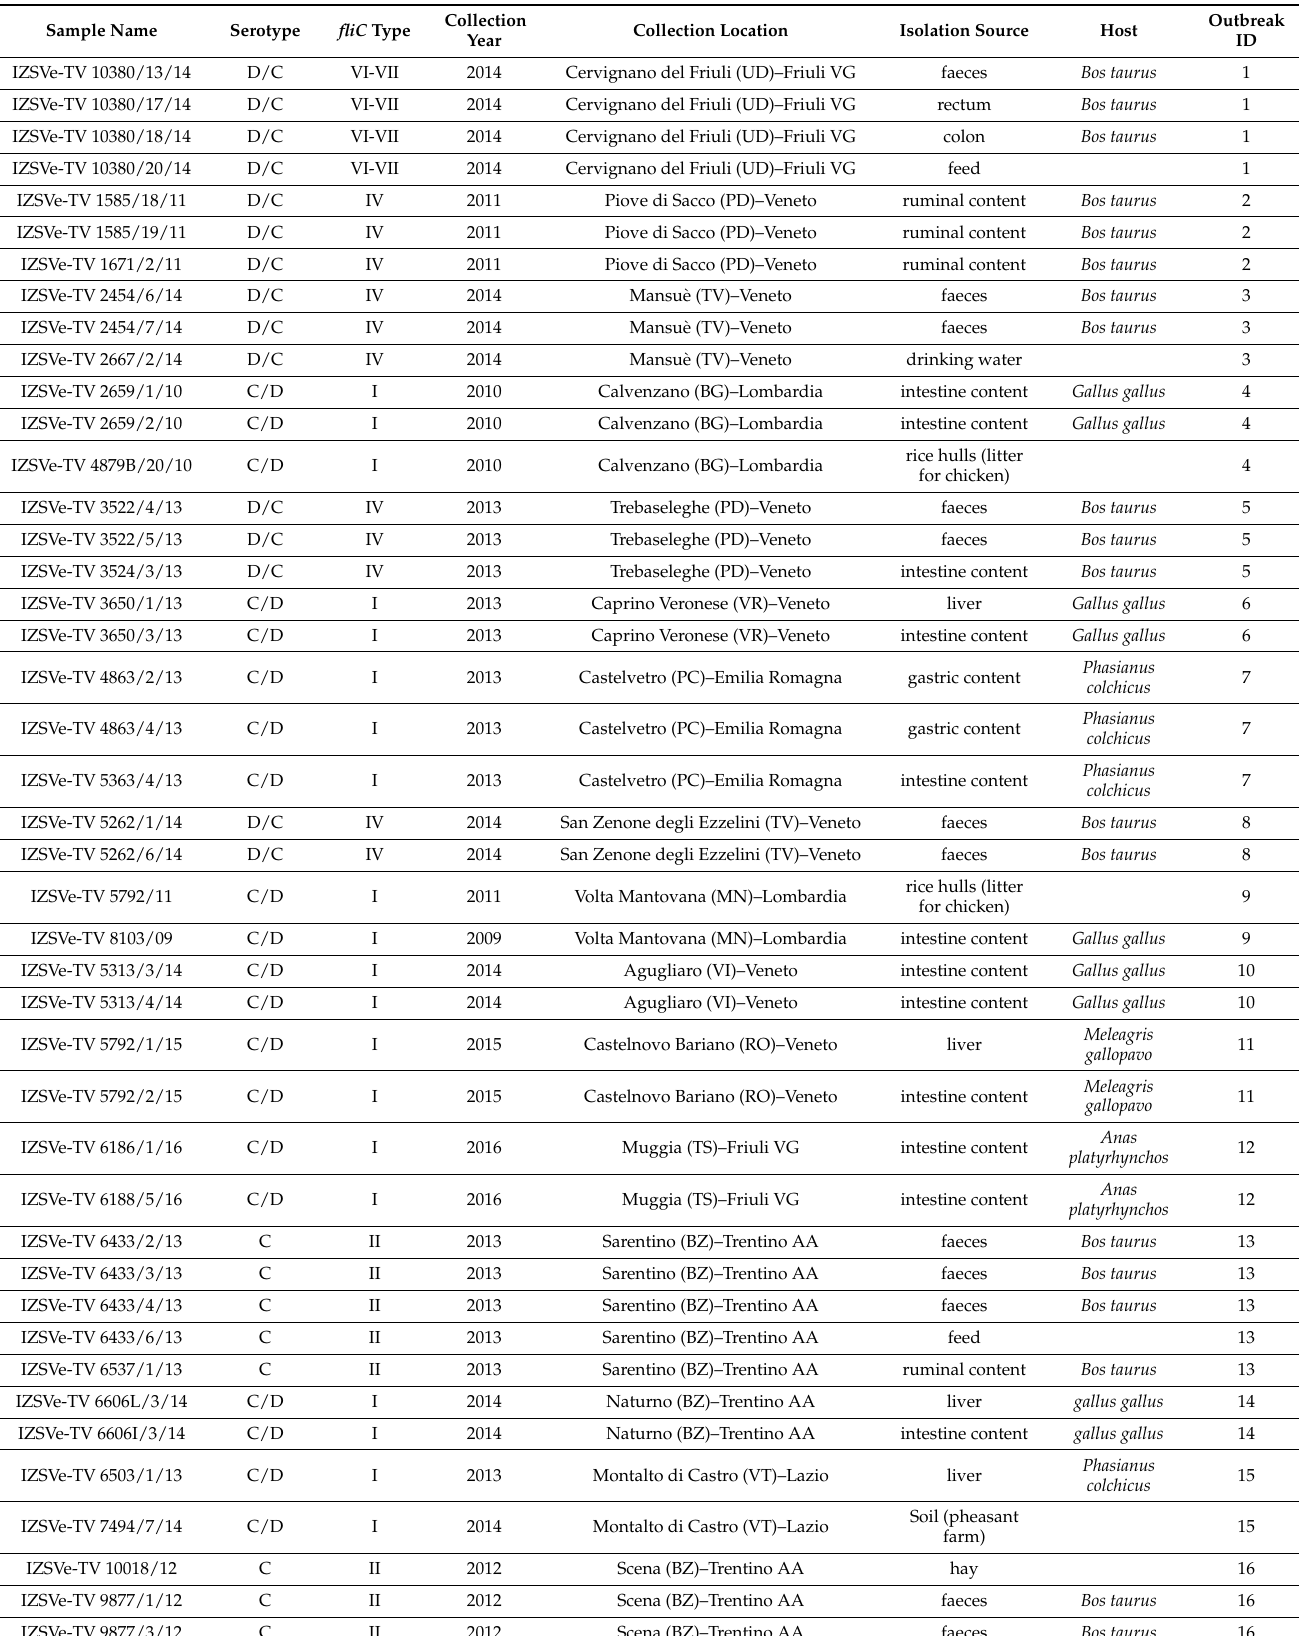
Table 1. Information on the new sequenced strains analyzed in the present